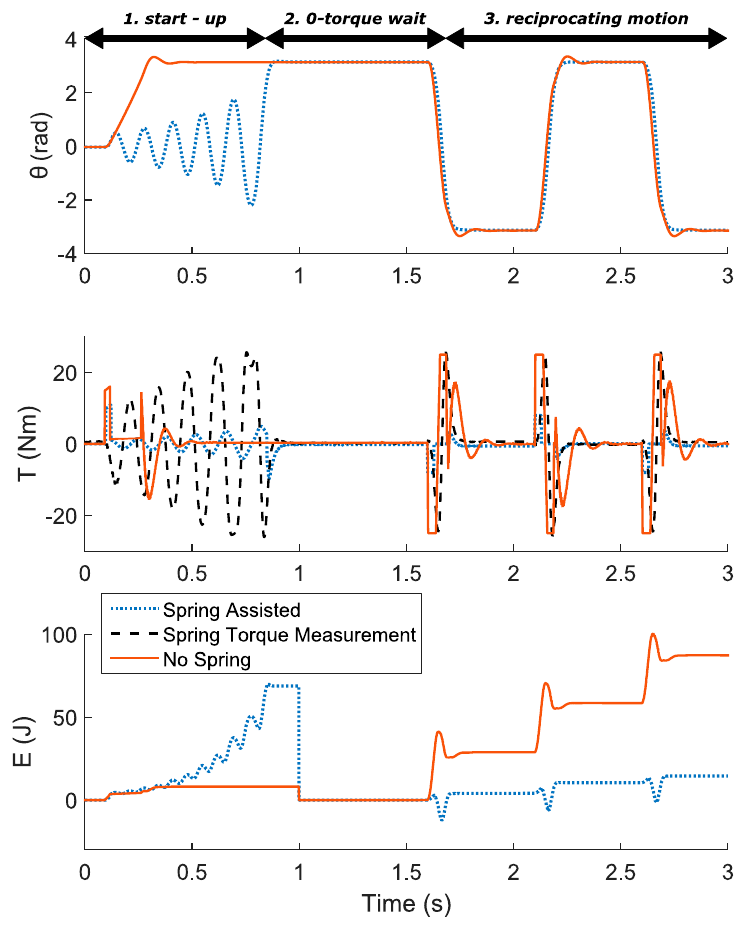
Figure 9. Proof-of-concept. Comparison of dynamic operational data for a magnetic spring with minimum motor torque vs. no spring setup with peak torque operation; controller structure and tuning have an impact on the exact values.